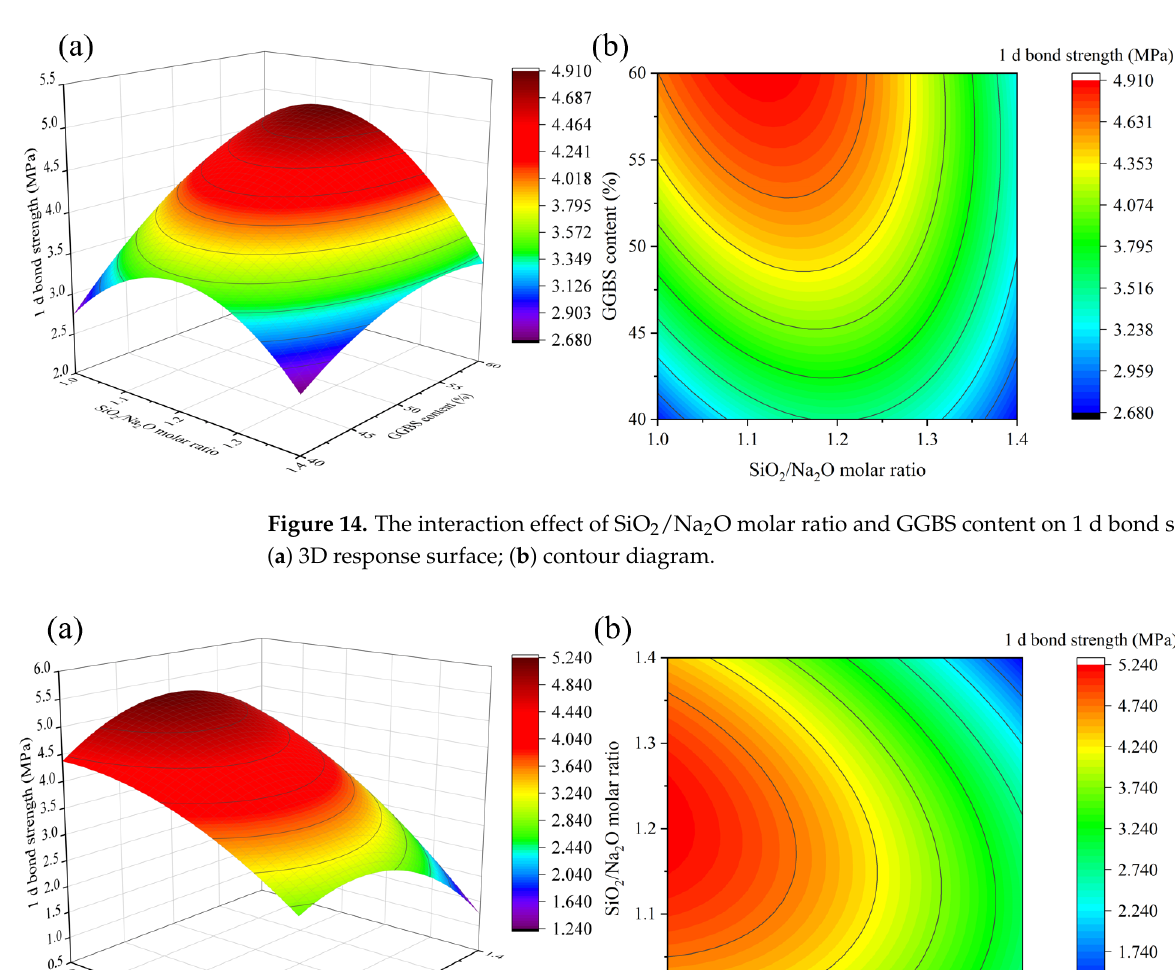
Figure 13. The interaction effect of Na 2 O/binder ratio and GGBS content on 1 d bond strength: ( a ) 3D response surface; ( b ) contour diagram.